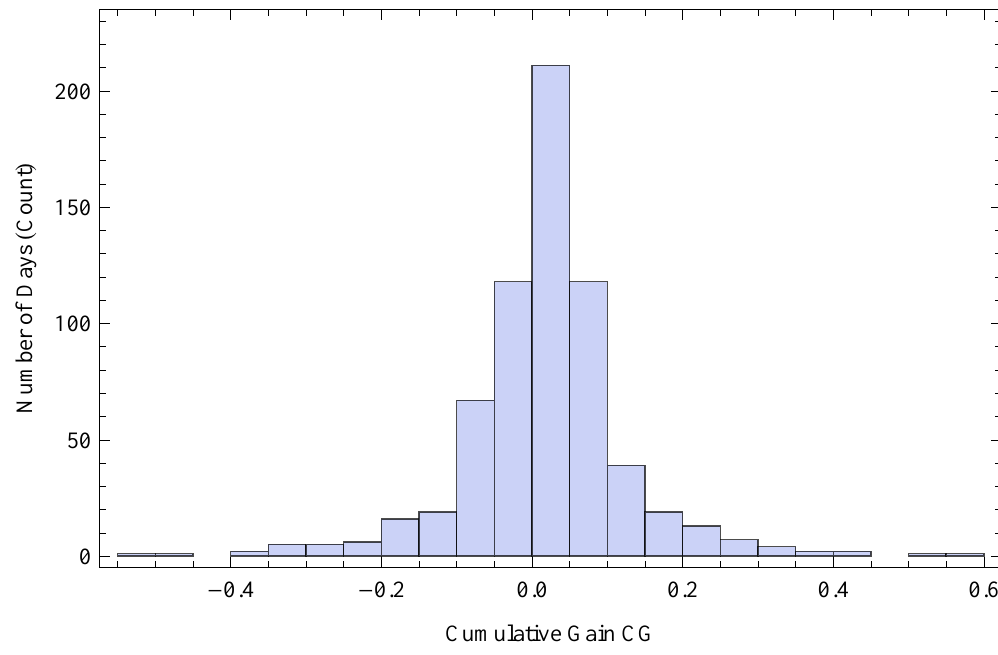
Figure 15. Histogram of the gains realized by picking the top 10 tickers chosen from the snapshot aggregation algorithm and selling after 20